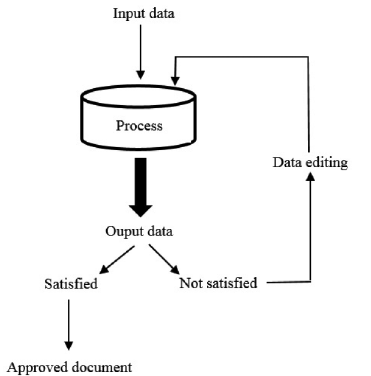
Figure 1. ALOL model